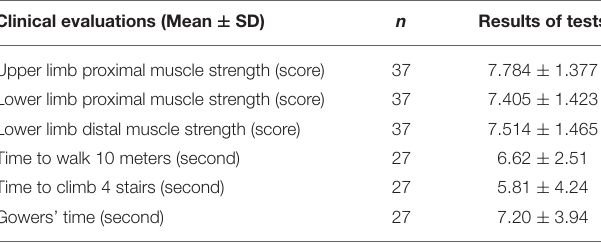
TABLE 4 | Results of the clinical evaluations of children with Duchenne muscular dystrophy.